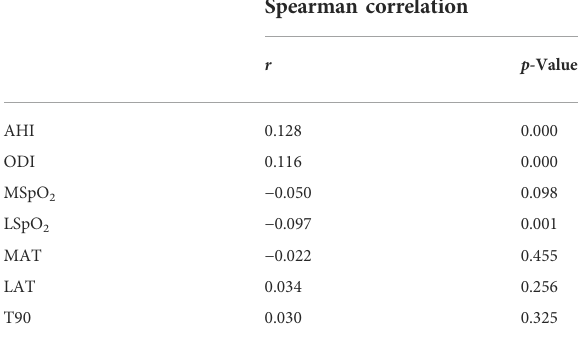
TABLE 2 Correlations between sleep parameters and Cys-C levels.